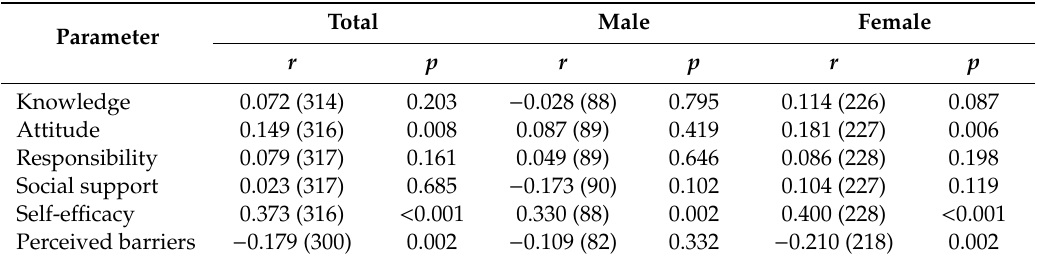
Table 6. Correlation between daily vegetable consumption and psychosocial determinants.